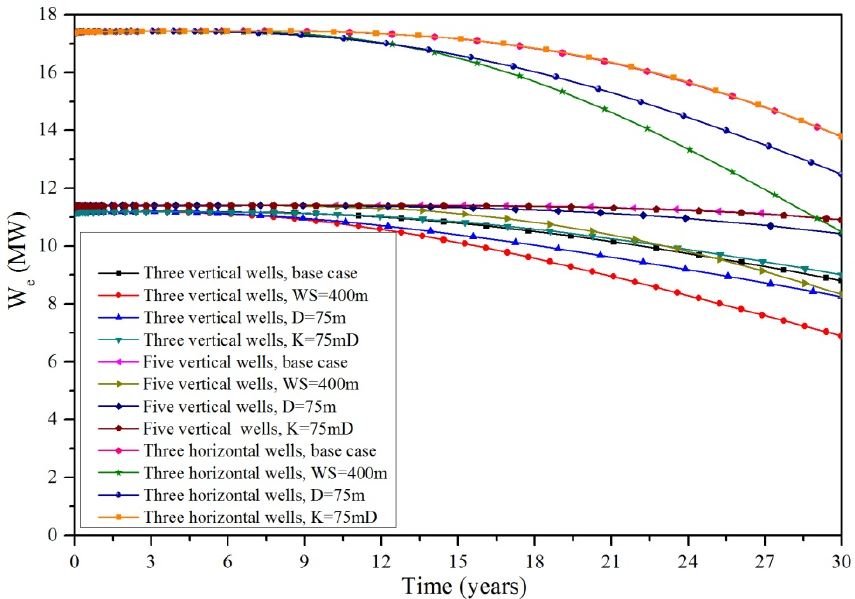
Figure 10. Sensitivity of electric power to main parameters.